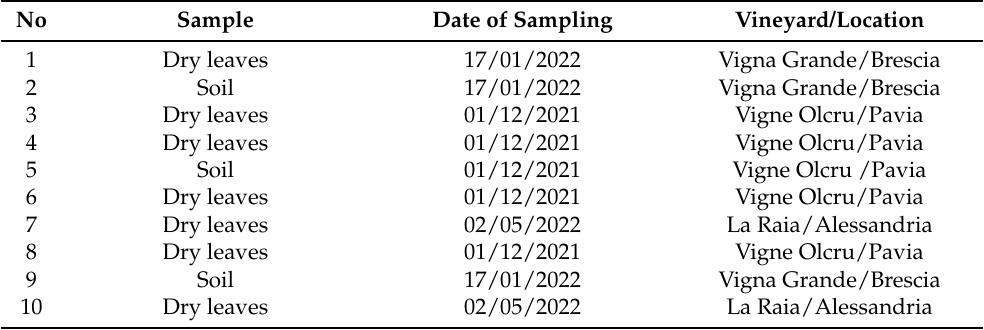
Table 1. Location and date of sampling of the ten environmental samples used to isolate the plant- associated